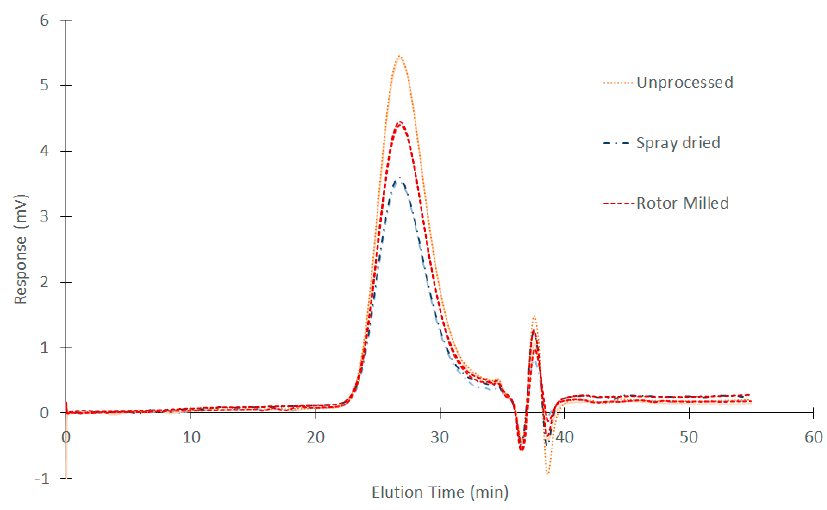
Figure 7. GPC measurements on unprocessed PSU, Rotor Milled powder subjected to the three step refinement process with additional sieving at 80 μ m and spray-dried PSU obtained at the best parameter settings. The second measurements are represented in a lighter shade of the representative color. Table 2. Gel Permeation Chromatography (GPC) measurements of virgin and processed